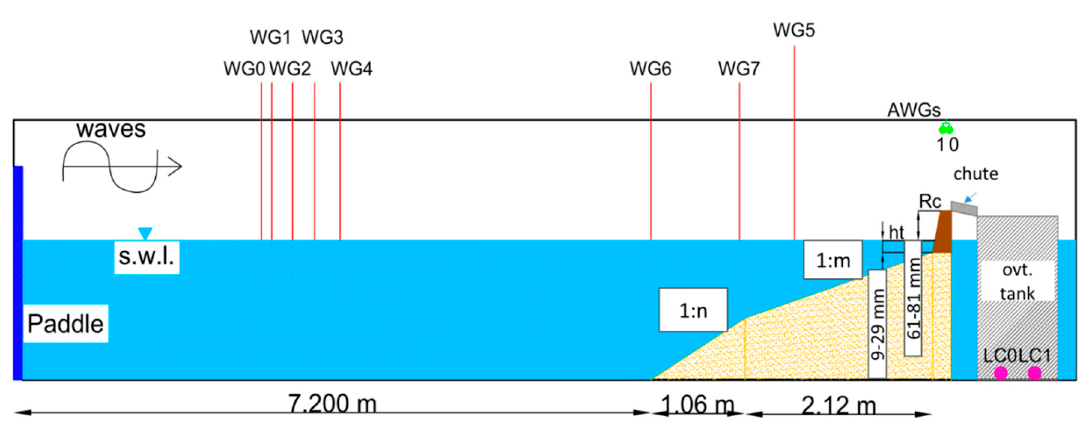
Figure 4. Bathymetry extracted from the LIM/UPC drone survey ( left plot ) and resulting profiles by merging existing data with the carried-out survey ( right plot ). A photo of the drone is in the small picture.